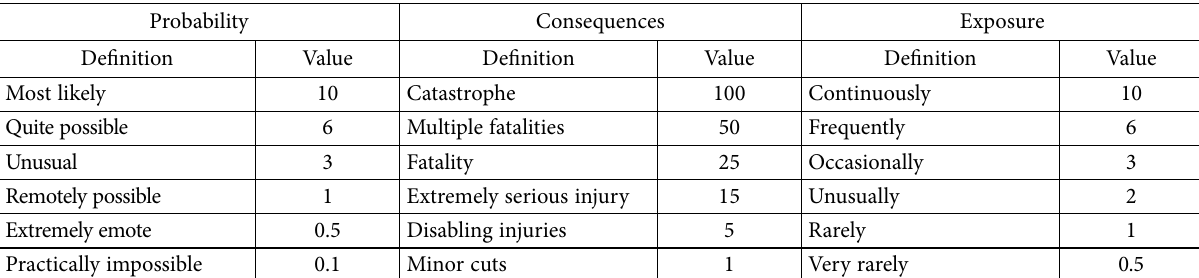
Table 1. Values for the parameters to calculate the risk score